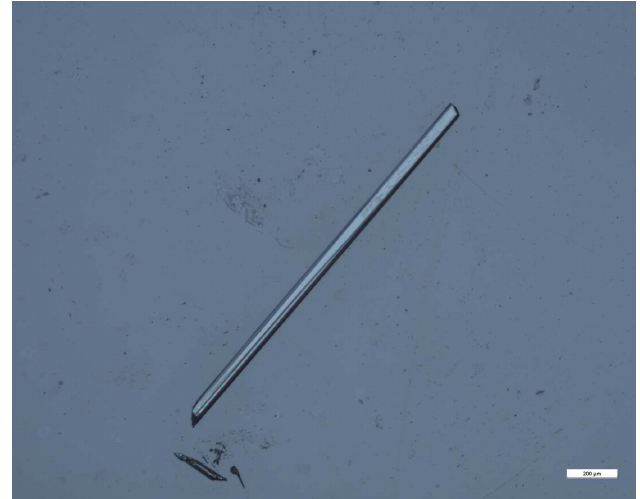
Figure 3 A representative crystal of I.